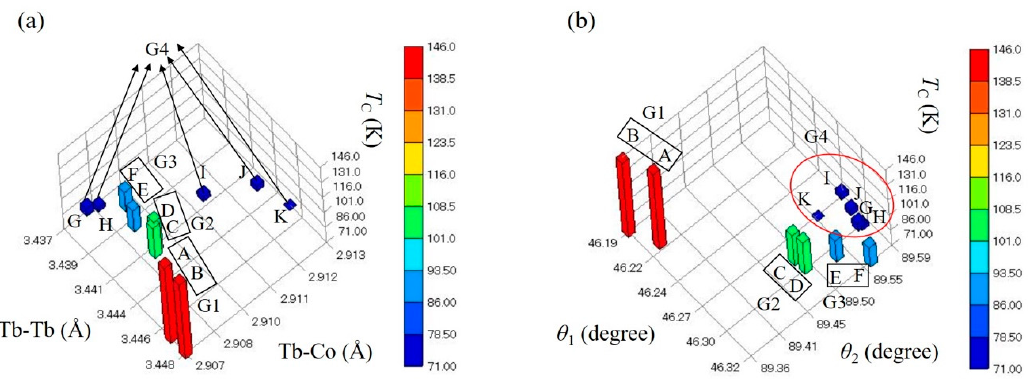
Figure 10. 3D bar graphs of T C as a function of ( a ) Tb–Tb and Tb–Co, and ( b ) θ 1 and θ 2 , respectively. The errors of Tb–Tb and Tb–Co distances are 0.0005 Å, 0.0003 Å, respectively. That of θ 1 and θ 2 is 0.007 ◦